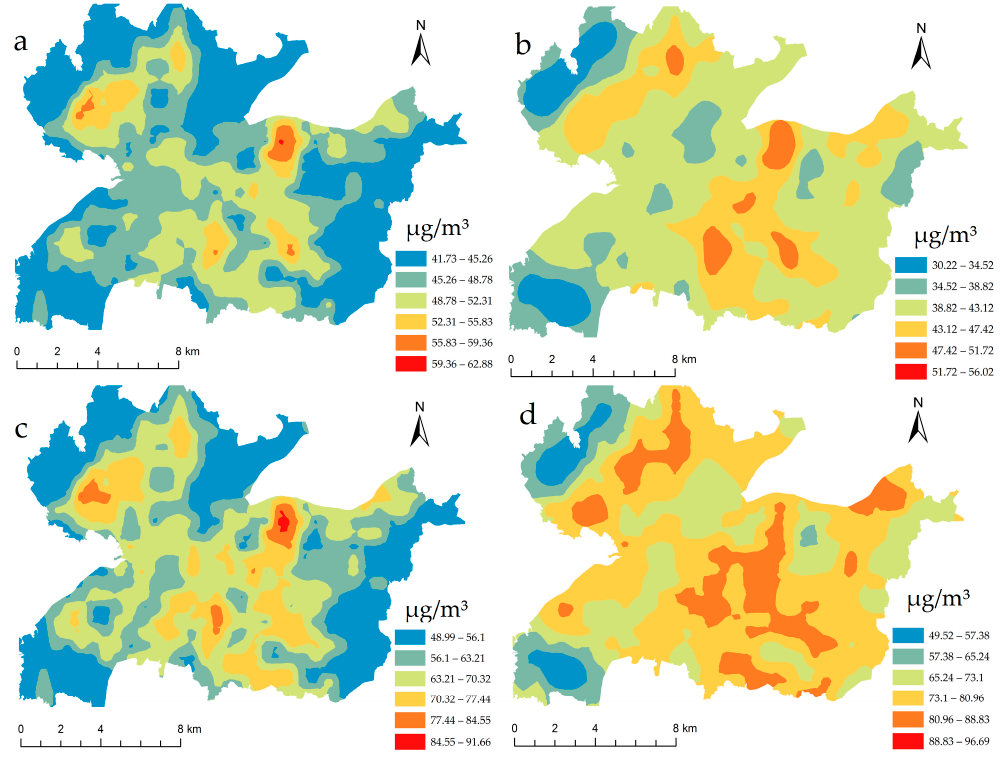
Figure 3. Final LUR models applied in the Nanchang urban area: PM 2.5 concentrations in ( a ) Spring; ( b ) Summer; ( c ) Autumn; ( d ) Winter.